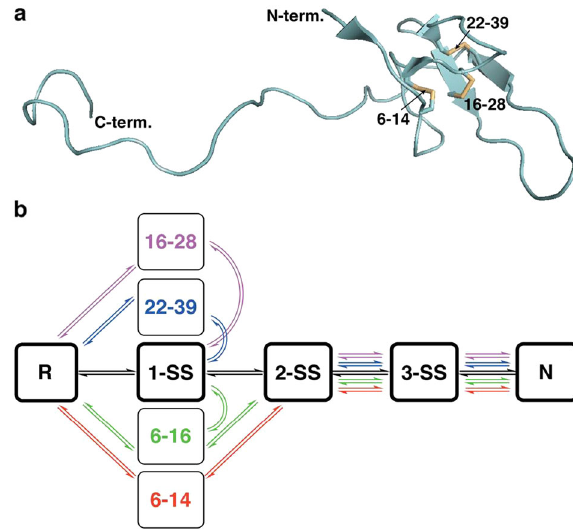
Fig. 1 The 3D structure and the 1proposed oxidative folding mechanism of hirudin. a 3D structure of WT-hirudin (WT-Hir; PDB entry: 1HRT) based on crystal structure of its complex with bovine thrombin (not shown